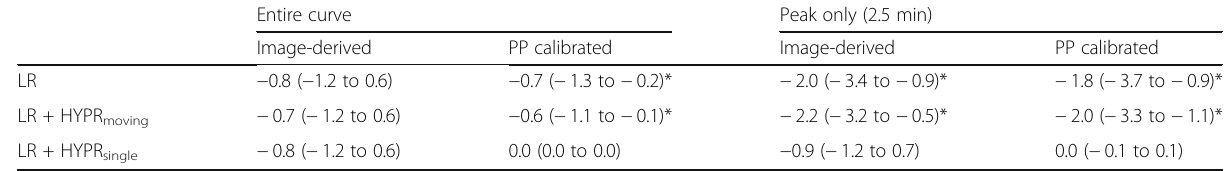
Table 1 Median relative differences (% with IQR) in IDIF AUC of PVC-images compared to uncorrected images Entire curve